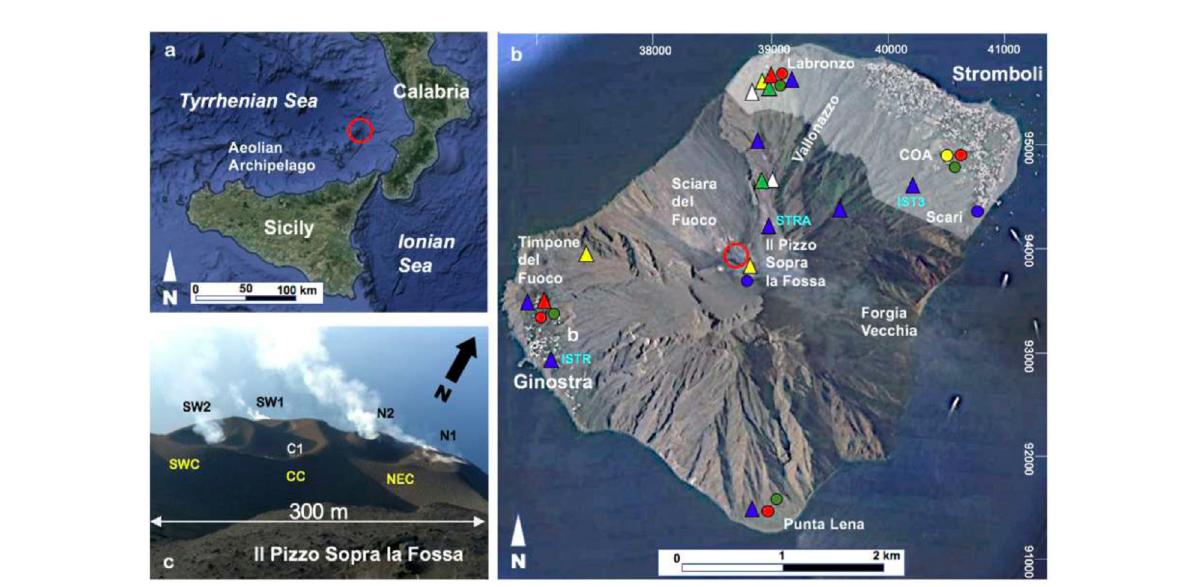
FIGURE 1 (A) GoogleEarth satellite imagery (7 July 2019) of southern Italy comprising Sicily, Calabria, the Aeolian Archipelago, with the position of Stromboli volcano marked by thered circle. (B) GoogleEarthsatellite imagery(7 July 2019) of Stromboliisland with thesummitcraters shown by the red empty circle, and indicating the distribution of the monitoring instruments used in this paper: yellow triangles: thermal cameras; white triangles: visiblecameras;greentriangles:GBInSARs;redtriangles:tiltmeters;yellowcircle:strainmeter;bluetriangles:seismicstations;redcircles:GNSS stations; green circles: FLAME stations for SO 2 measurements; blue circles: soil CO 2 monitoring stations. The light shaded area in the NE side of the island identi fi esthedeposit of19 May2021 ashcloud. (C) Photo ofStrombolitakenby Francesco Ciancittoon 13January2020 fromIlPizzoSopra la Fossa,showingfromtheSouththewholecraterterrace(the fi eldofviewis~300 mwide),thesummitcraterzones(SWC,SWcraterzone;CC,central crater zone; NEC, NE crater zone) and the active vents C1, N1, N2, SW1 and